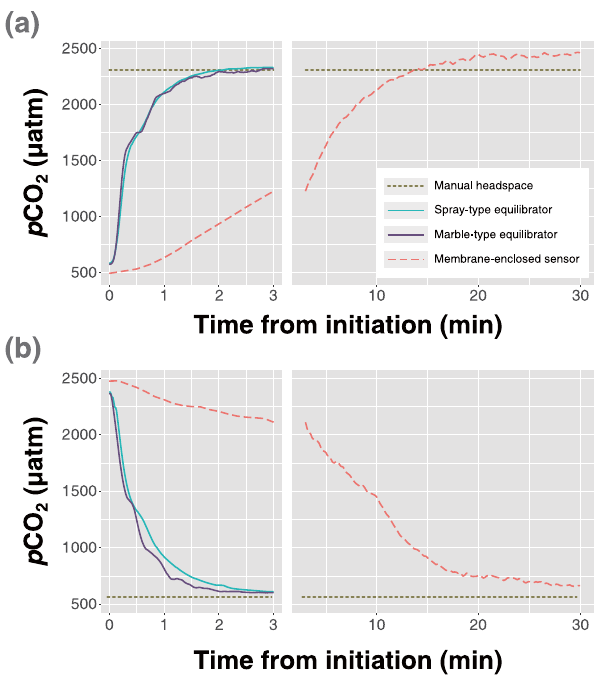
Figure 2. Laboratory cross-validation tests of three gas equilibra- tion systems during (a) low-to-high and (b) high-to-low equilibra-